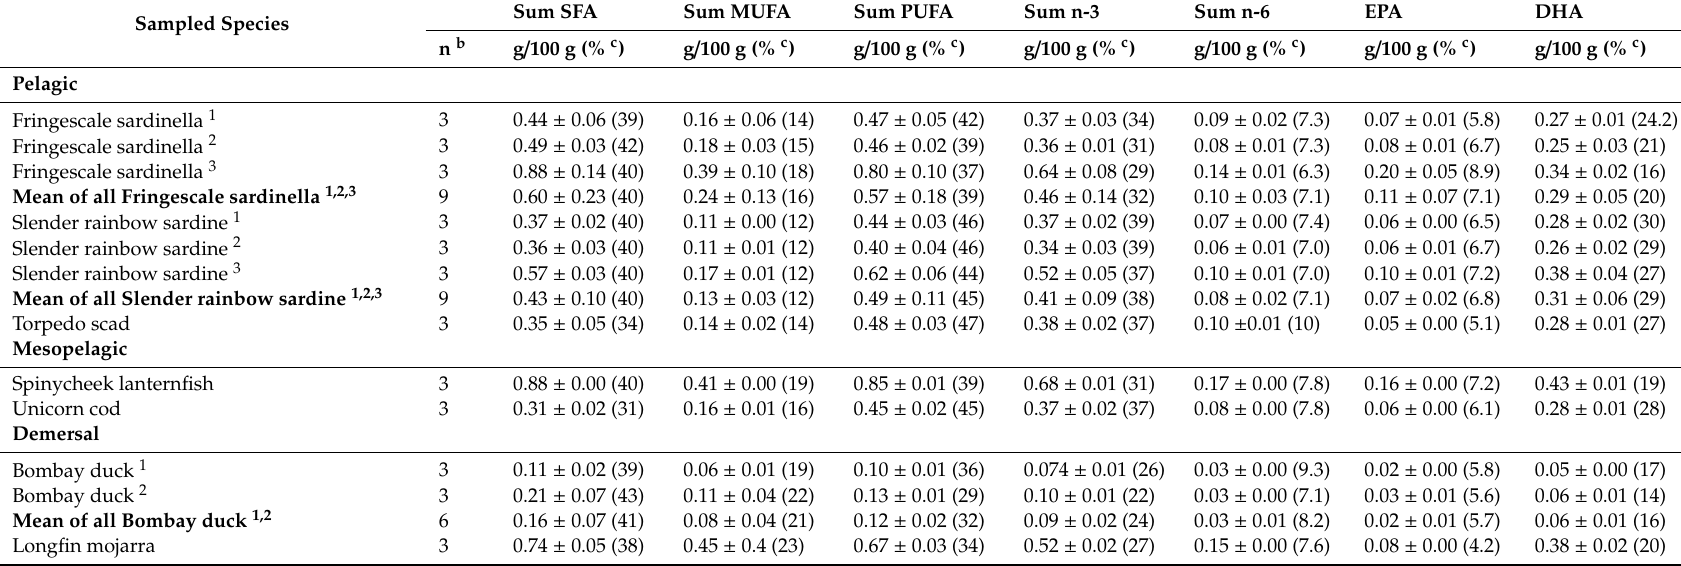
Table 6. Analytical values of the fatty acid composition of fish species sampled from Bangladesh a